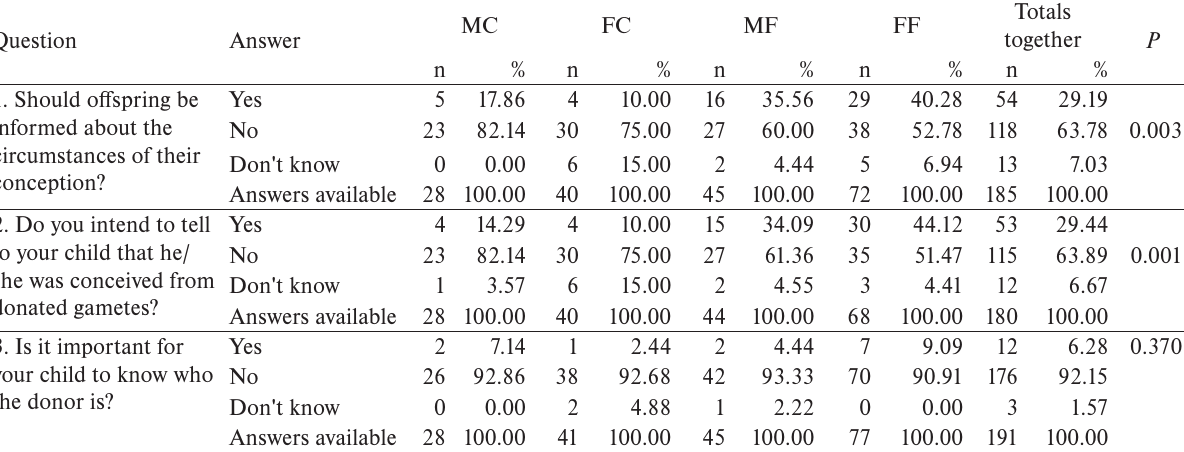
Table 2. The couple’s main attitudes towards openness or secrecy concerning the mode of conception to the child grouped by gender and nationality. Male Czech (MC), female Czech (FC), male foreigner (MF) and female foreigner (FF) are considered; relationship was evaluated using Chi-square